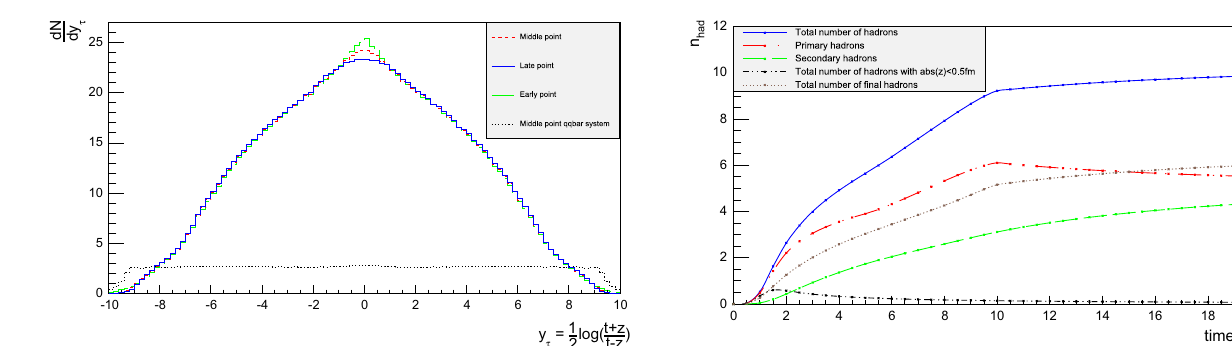
Fig. 15 Longitudinal spectra for pp events and q ¯ q systems, both at √ s = 13 TeV